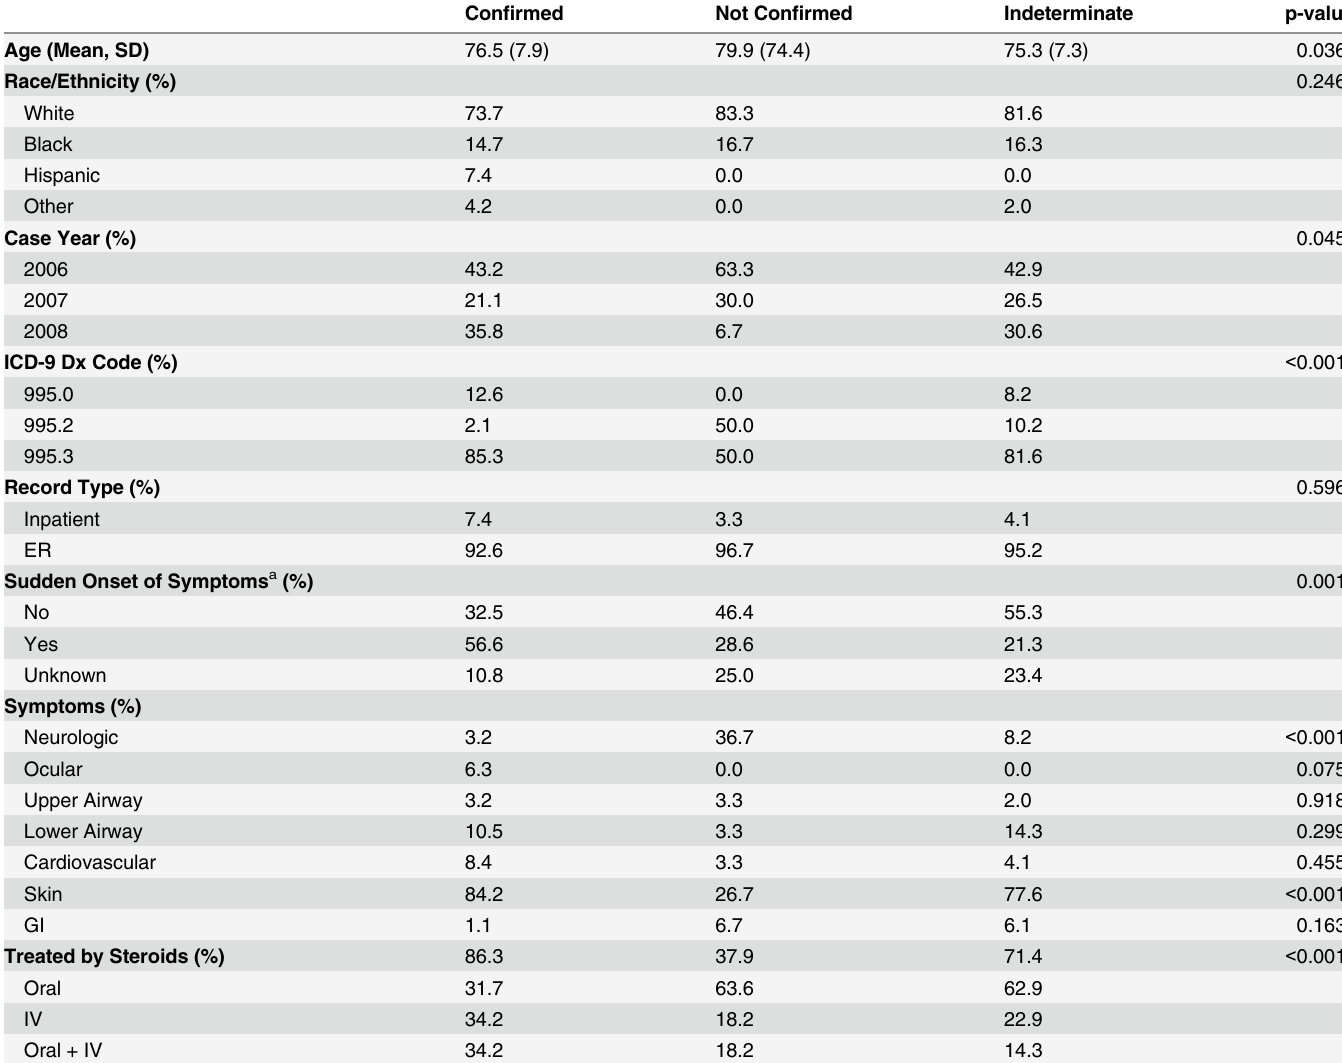
Table 5. Characteristics by Hypersensitivity Case Determination